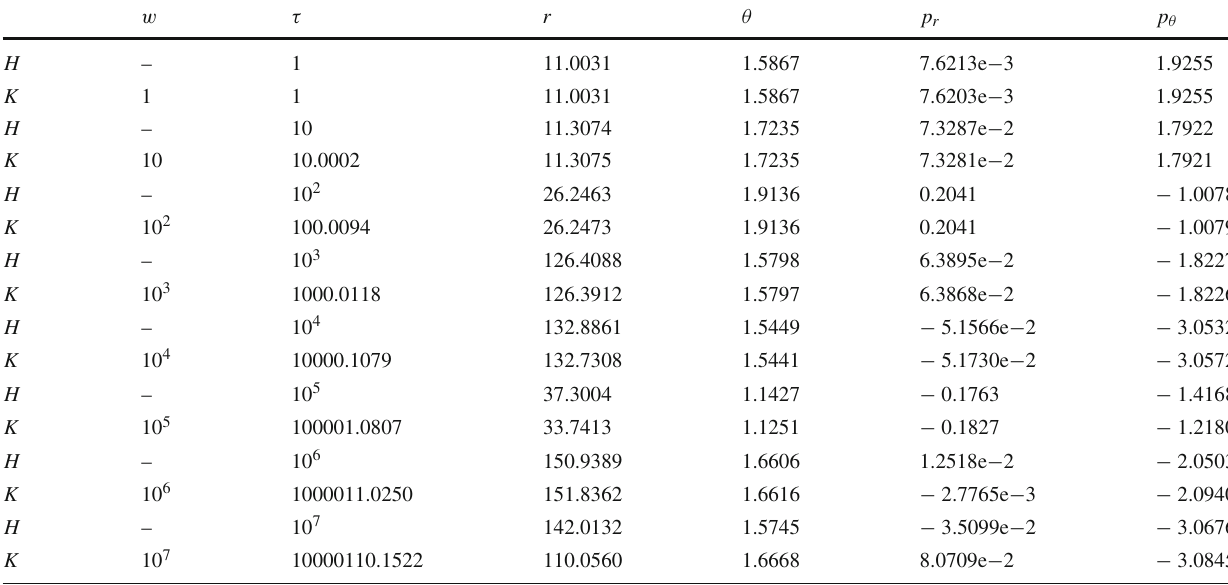
Table 1 Solutions for the methods S2 and IE2 solving Orbit 1 in Fig. 1a. The two systems H and K almost have the same solutions in an integration time of τ = 10000 or w =